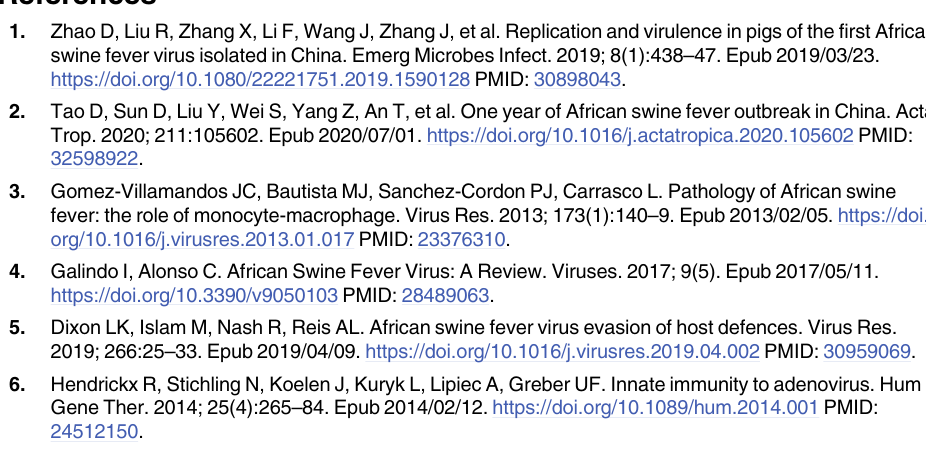
S1 Table. Primers, siRNA and sgRNA used in this study. S2 Table. The DNA sequence covering the modified region of